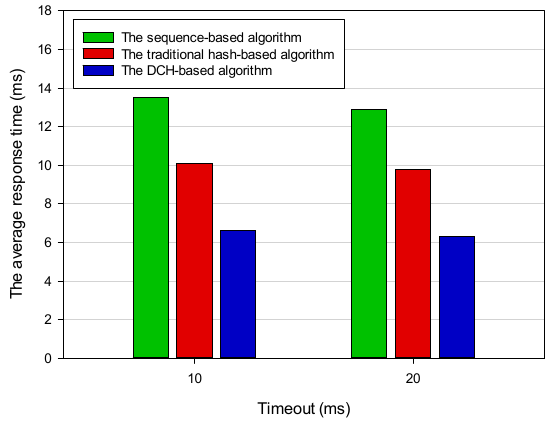
Figure 14. The average response time based on different deploying algorithms.